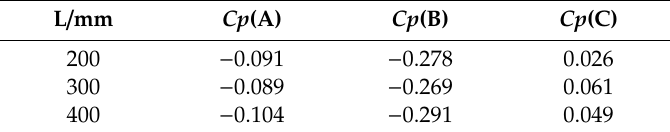
Table 7. Typical pressure coe ffi cient of the BWB aircraft with di ff erent straight-section lengths Figure 9. Support interference results of the BWB aircraft with different straight-section lengths (L = (L = 200 mm / 300 mm / 400 mm, Ma = 0.75, α = 0 ◦ . The position of point A / B / C is shown in Figure 10a).